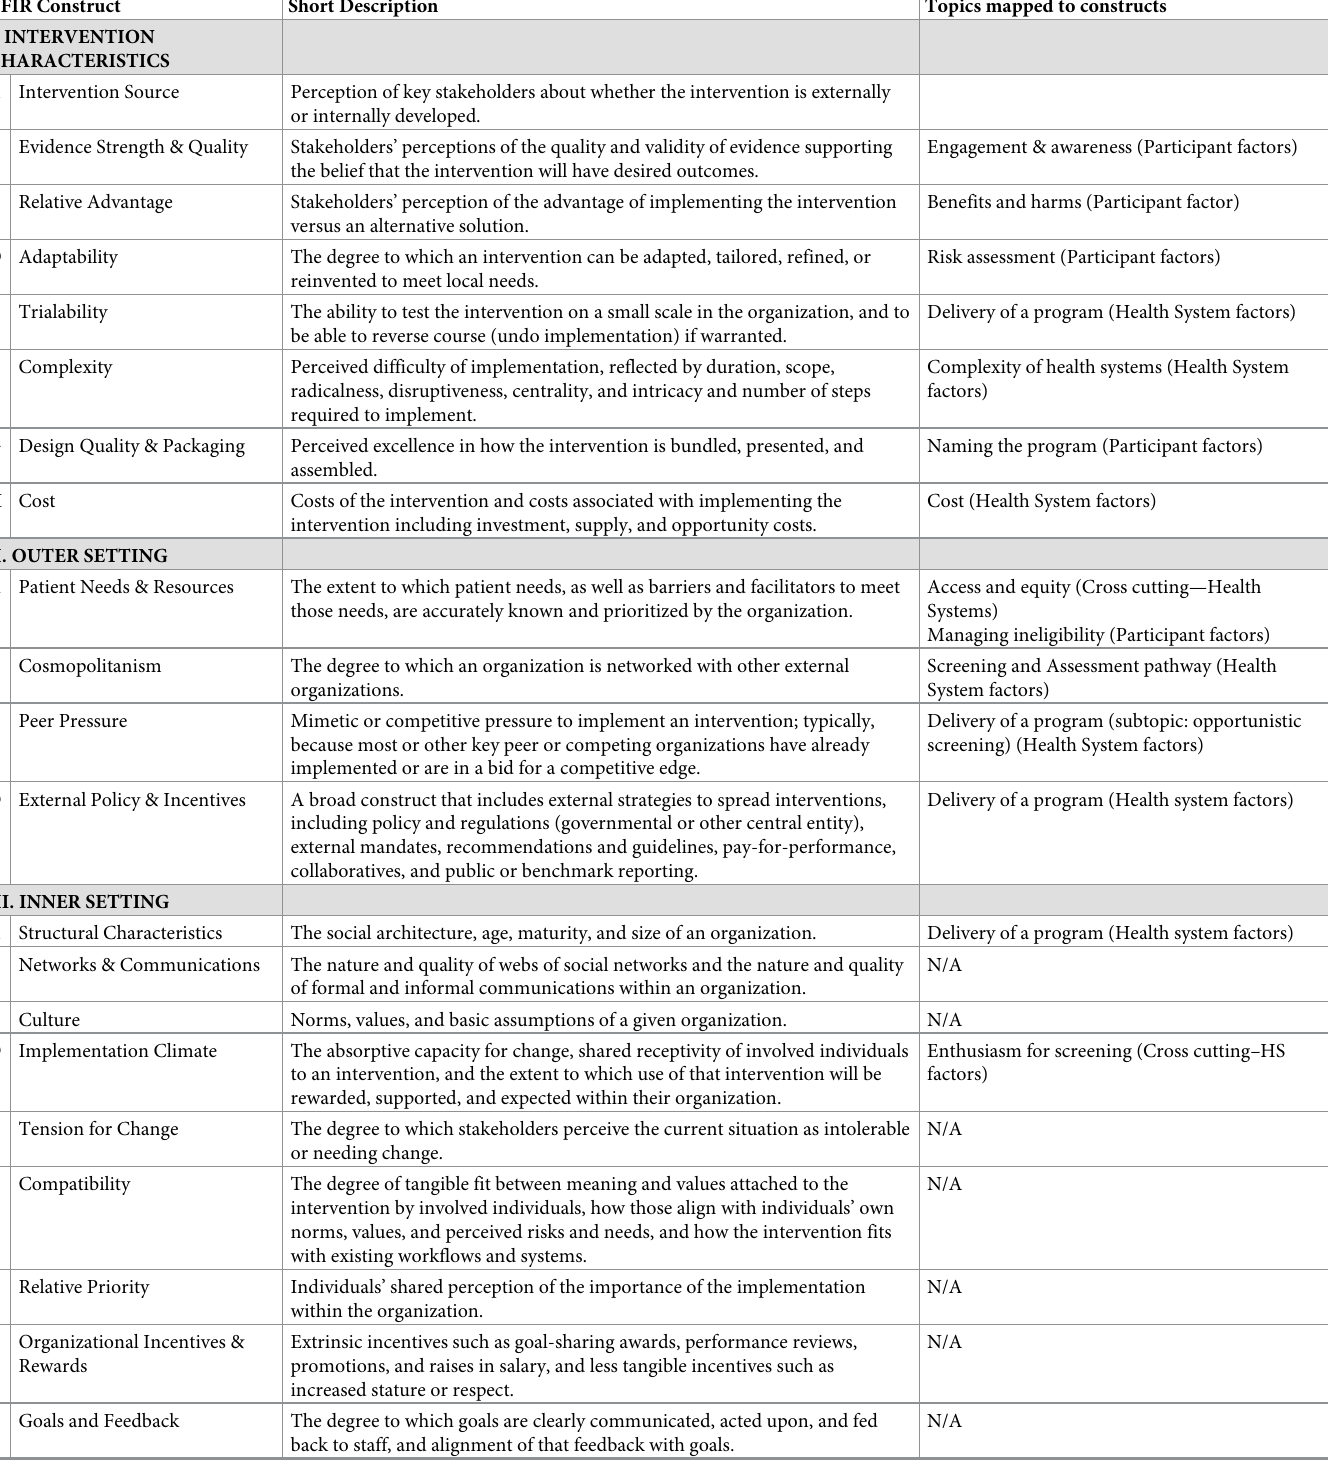
Table 2. Mapping of participant and health system factor topics to CFIR constructs inclusive of CFIR descriptions. CFIR